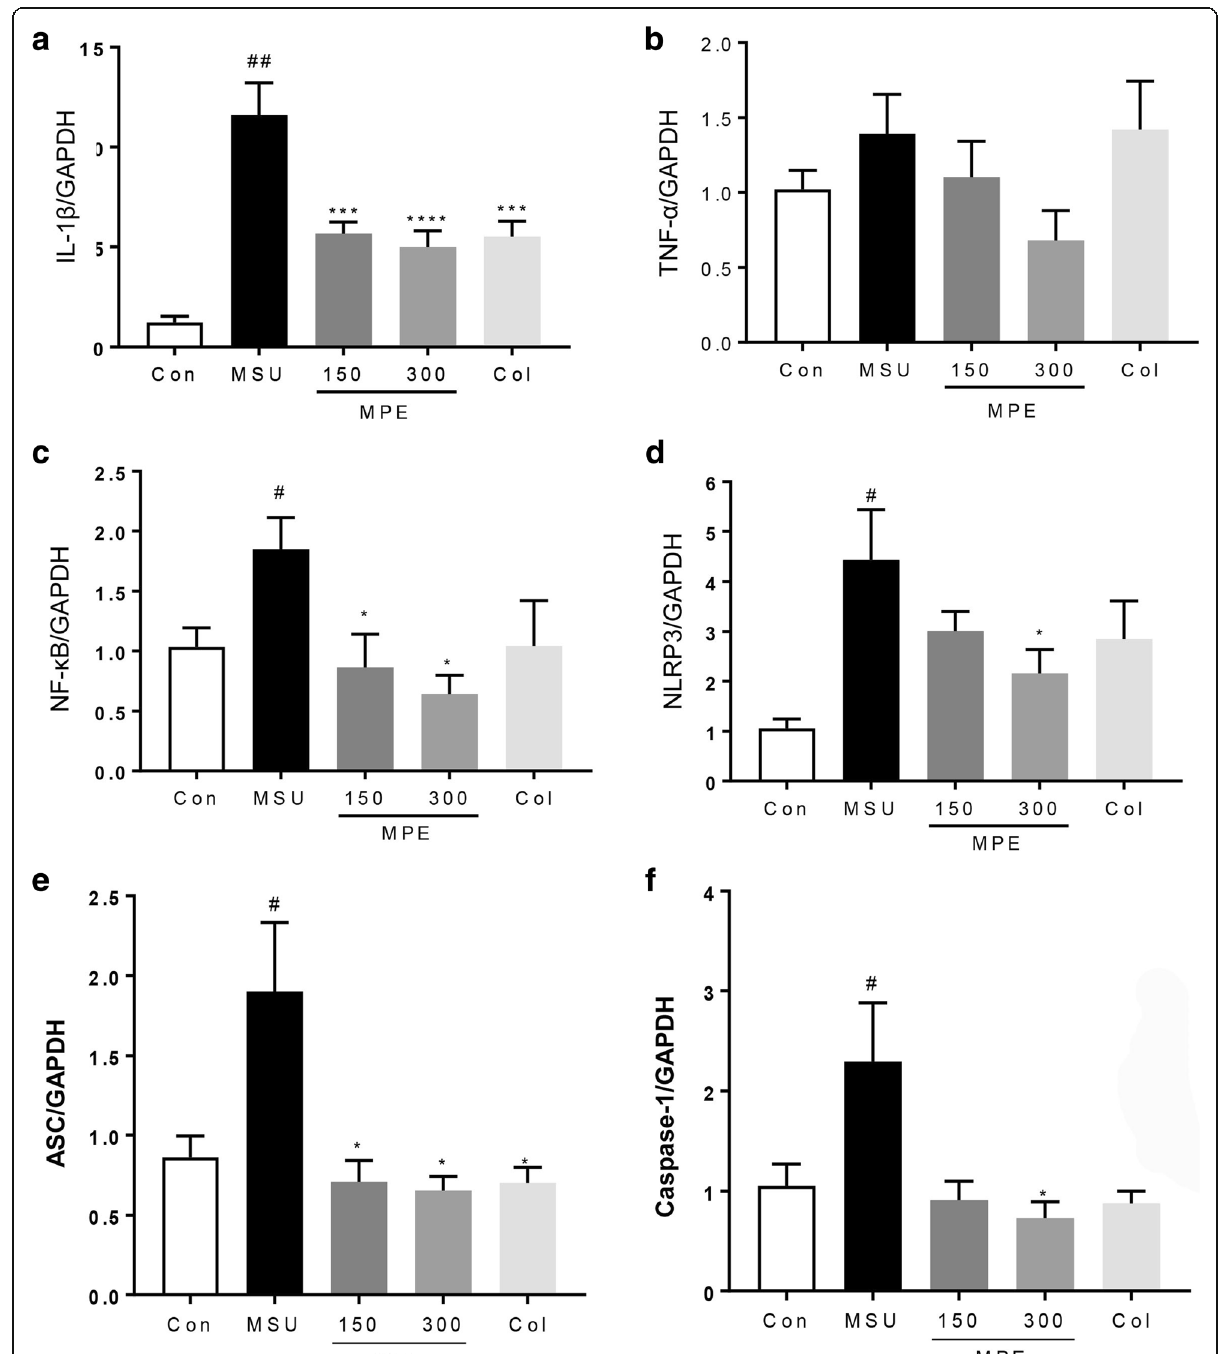
Fig. 4 Effects of MPE on the expression of cytokines in the paw tissue of mouse with MSU crystal-induced gouty arthritis. Con, control mice; MSU, MSU crystal-induced mice; MPE, MSU mice treated with 150/300 mg/kg of MPE; Col, MSU mice treated with 1 mg/kg of colchicine. Expression of a IL-1 β , b TNF- α , c NF- κ B, d NALP3, e ASC and f Caspase-1 mRNA was determined by real-time RT-PCR. The mRNA expression levels were normalized to GAPDH mRNA level. Data are presented as the mean ± SEM ( n = 5). # p < 0.05 and ## p < 0.0001 vs. control group; * p < 0.05, *** p < 0.001 and **** p < 0.0001 vs. MSU